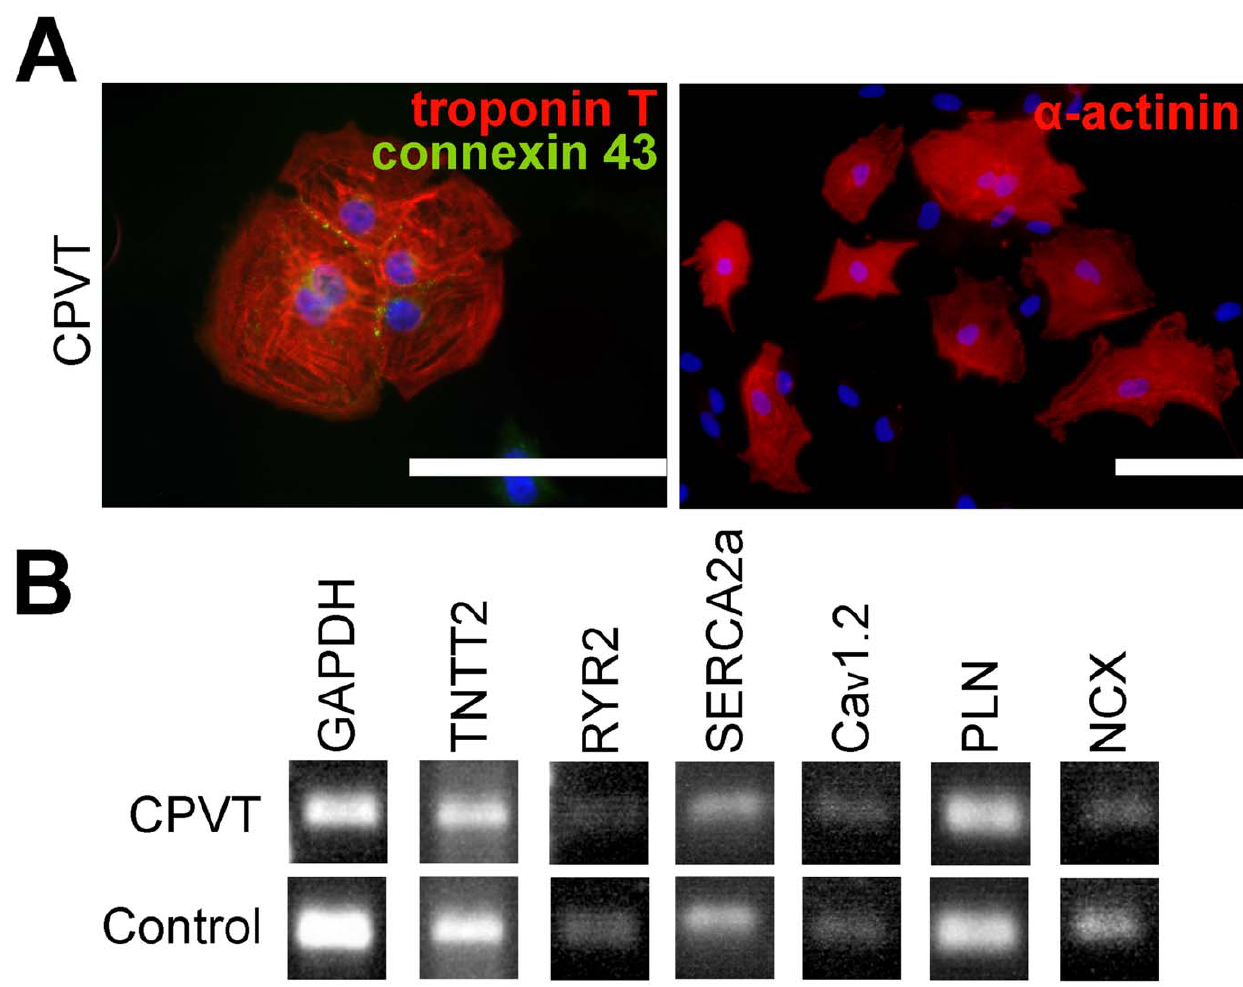
Figure 2. Characterization of iPSC-derived CPVT CMs. A , Immunocytochemical staining of cardiac markers, blue represents DAPI-staining for nuclei. Scale bars 100 m m. B , The expression of Ca 2 + cycling genes in differentiated CMs shown by RT-PCR. GAPDH is used as a housekeeping